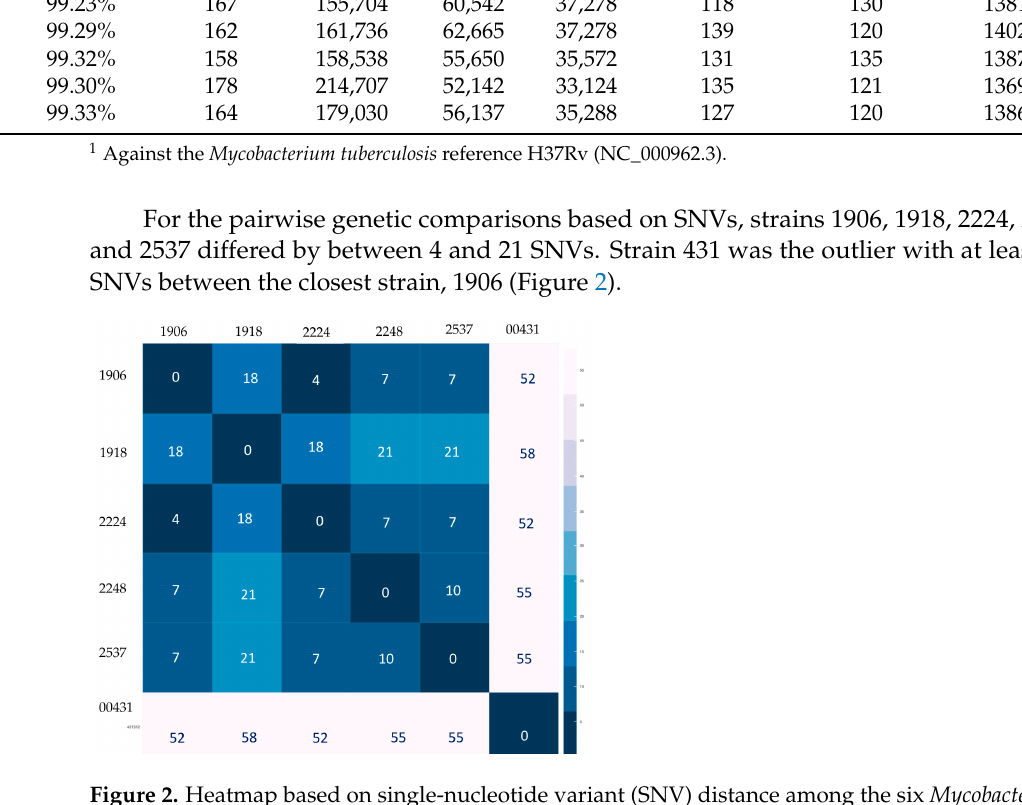
Figure 1. Phylogenetic tree ( A ) based on 24-MIRU-VNTR loci analysis on six Mycobacterium tuberculosis strains highlighting the quadruple-locus variation on strain 431 and a single-locus variation on strains 2224; identical spoligotyping profile ( B ) indicative of the Central-Asia (CAS) SIT 2545 genotype.